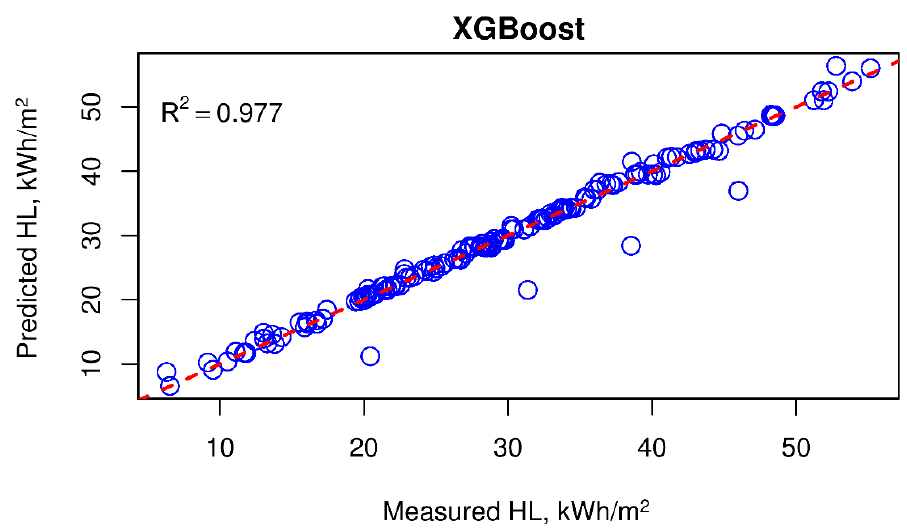
Figure 12. The results of HL prediction from the XGBoost model. 19